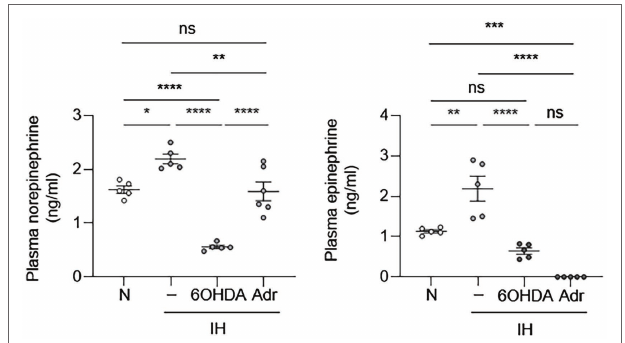
FIGURE 3 | Intermittent hypoxia increases systemic catecholamine levels. We exposed C57BL/6 mice to either normoxia (N) or IH for 10 days in the absence or presence of 6-hydroxydopamine (6OHDA), which depletes catecholamines. We also exposed adrenalectomized (Adr) mice to IH for 10 days. At the end of experiments, we collected plasma and measured catecholamine (epinephrine and norepinephrine) levels. N = 5–6. Significance was determined by one-way ANOVA using Bonferroni’s correction. ns, not significant. * p < 0.05, ** p < 0.005, *** p < 0.001, and **** p <